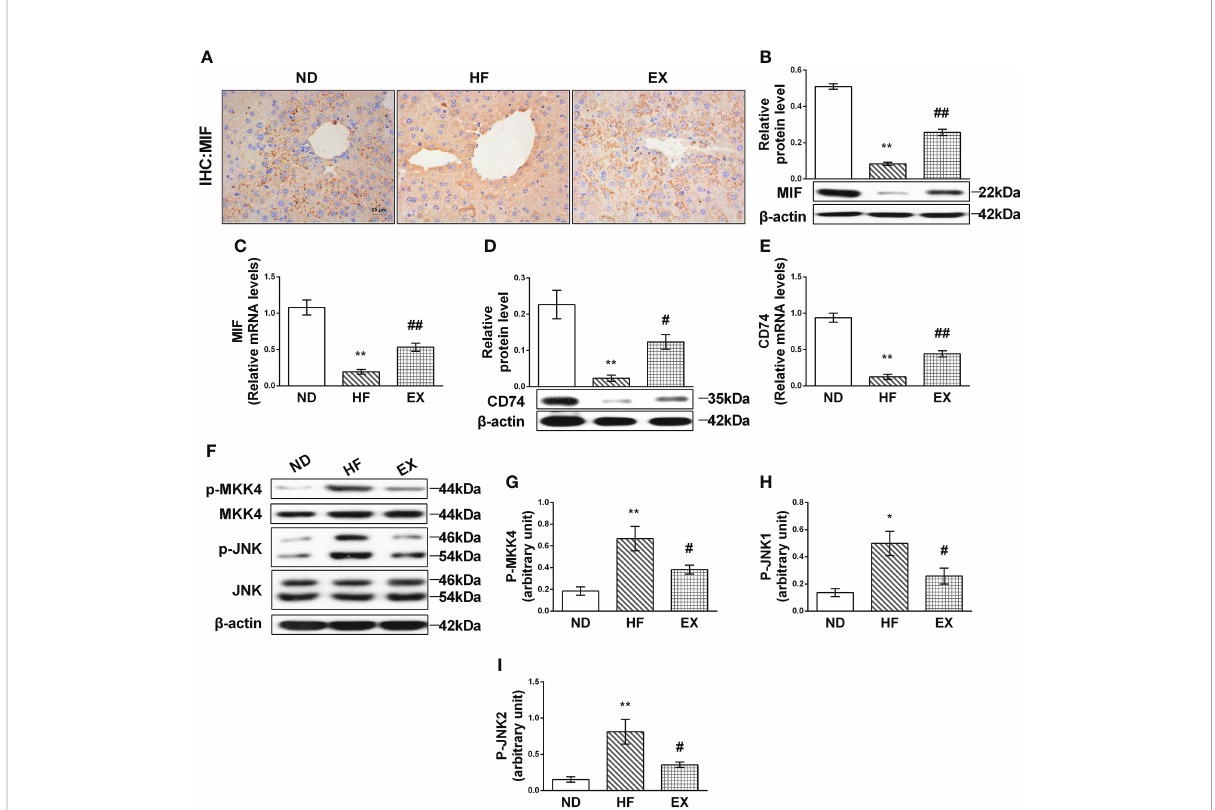
FIGURE 3 Effect of exercise on MIF-mediated JNK pathway in high-fat diet – induced NAFLD mice. Representative images of liver sections stained with MIF ( n = 3 per group) (A) . Relative protein expression and mRNA levels of MIF (B, C) and CD74 (D, E) were measured by Western blot analysis ( n = 3 per group) and qRT-PCR ( n = 5 per group). MKK4 (G) and JNK (H, I) were assessed in homogenates from liver tissue by immunoblotting with phospho-speci fi c and total antibodies ( n = 3 per group). Quanti fi cation of immunoblots is shown in graphs (A) . M ± SEM. * P < 0.05 versus